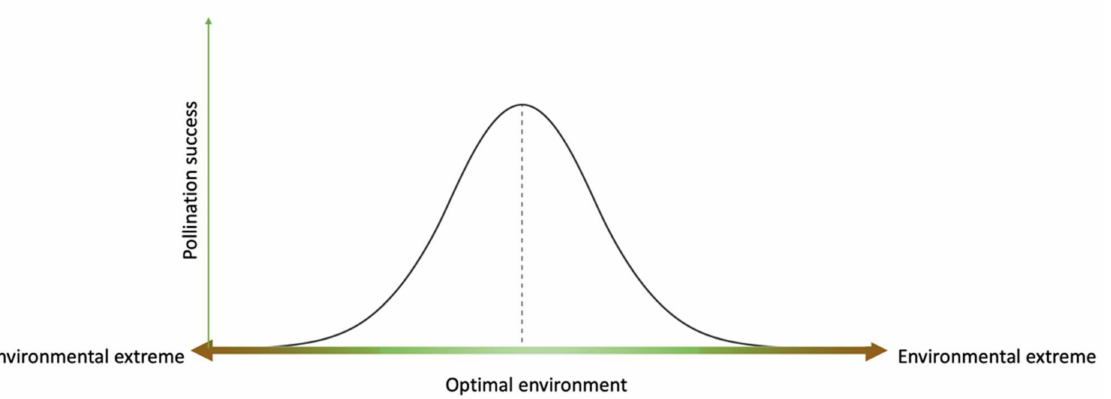
Figure 4. The relationship between environment and pollination success. As the environmental conditions move away from the optimum conditions, pollination outcomes rapidly diminish